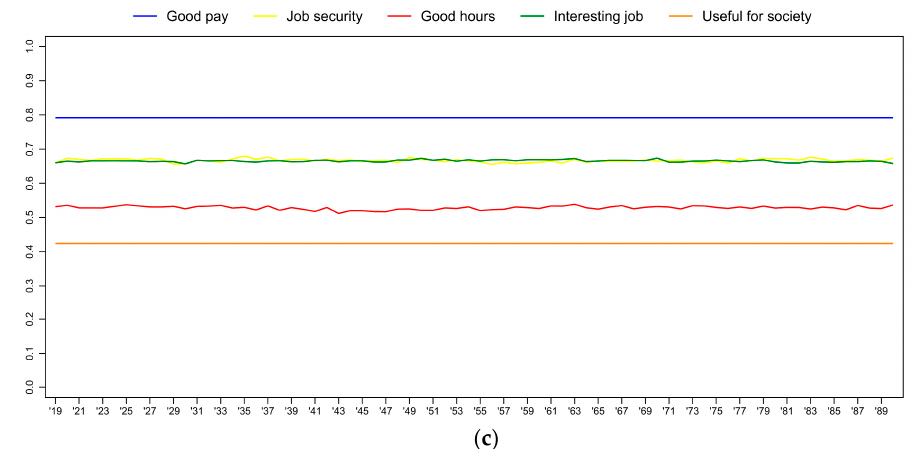
Figure 4. ( a ) Age, ( b ) period, and ( c ) birth-cohort effects on importance of work values (hierarchical age-period-cohort regression model). The y -axis shows the predicted value of the dependent variable (for an average respondent).